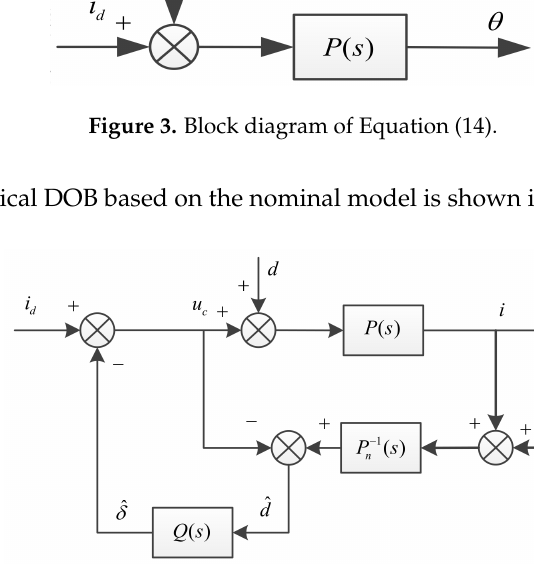
Figure 4. Typical disturbance